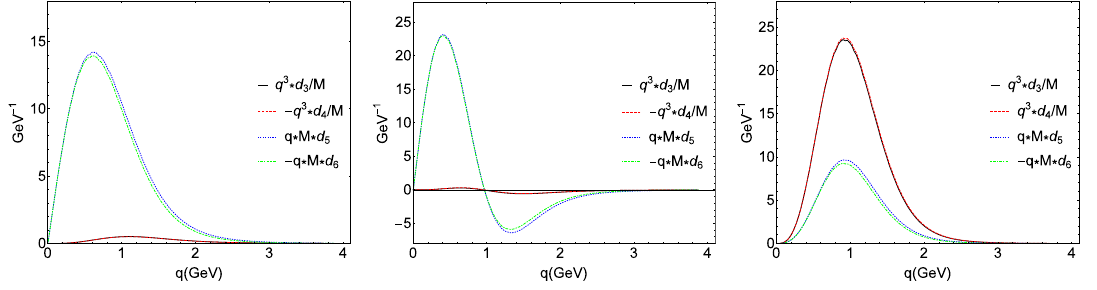
Figure 3 . The 1 − wave functions of the B ∗ B ∗ (1 D ) (right). c 3 and c 4 terms are D waves; c 5 and c 6 terms are S waves. c